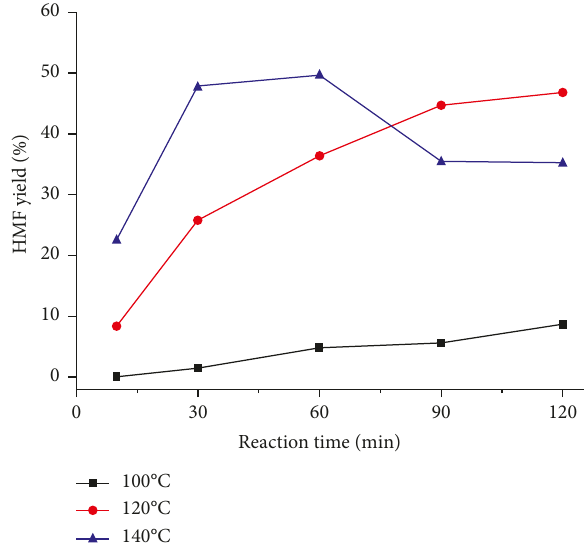
Figure 2: Effect of reaction time and temperature on fructose dehydration to HMF with S-AlMo catalyst. Reaction conditions: fructose (50mg), S-AlMo catalyst (20mg), and DMSO